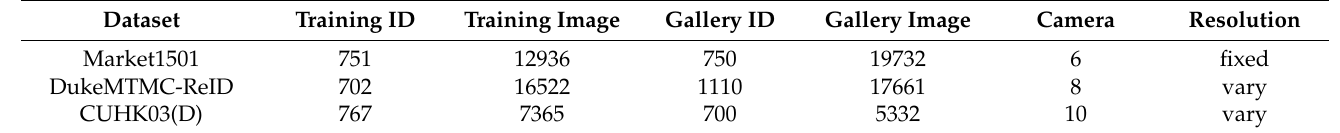
Table 1. Statistics of